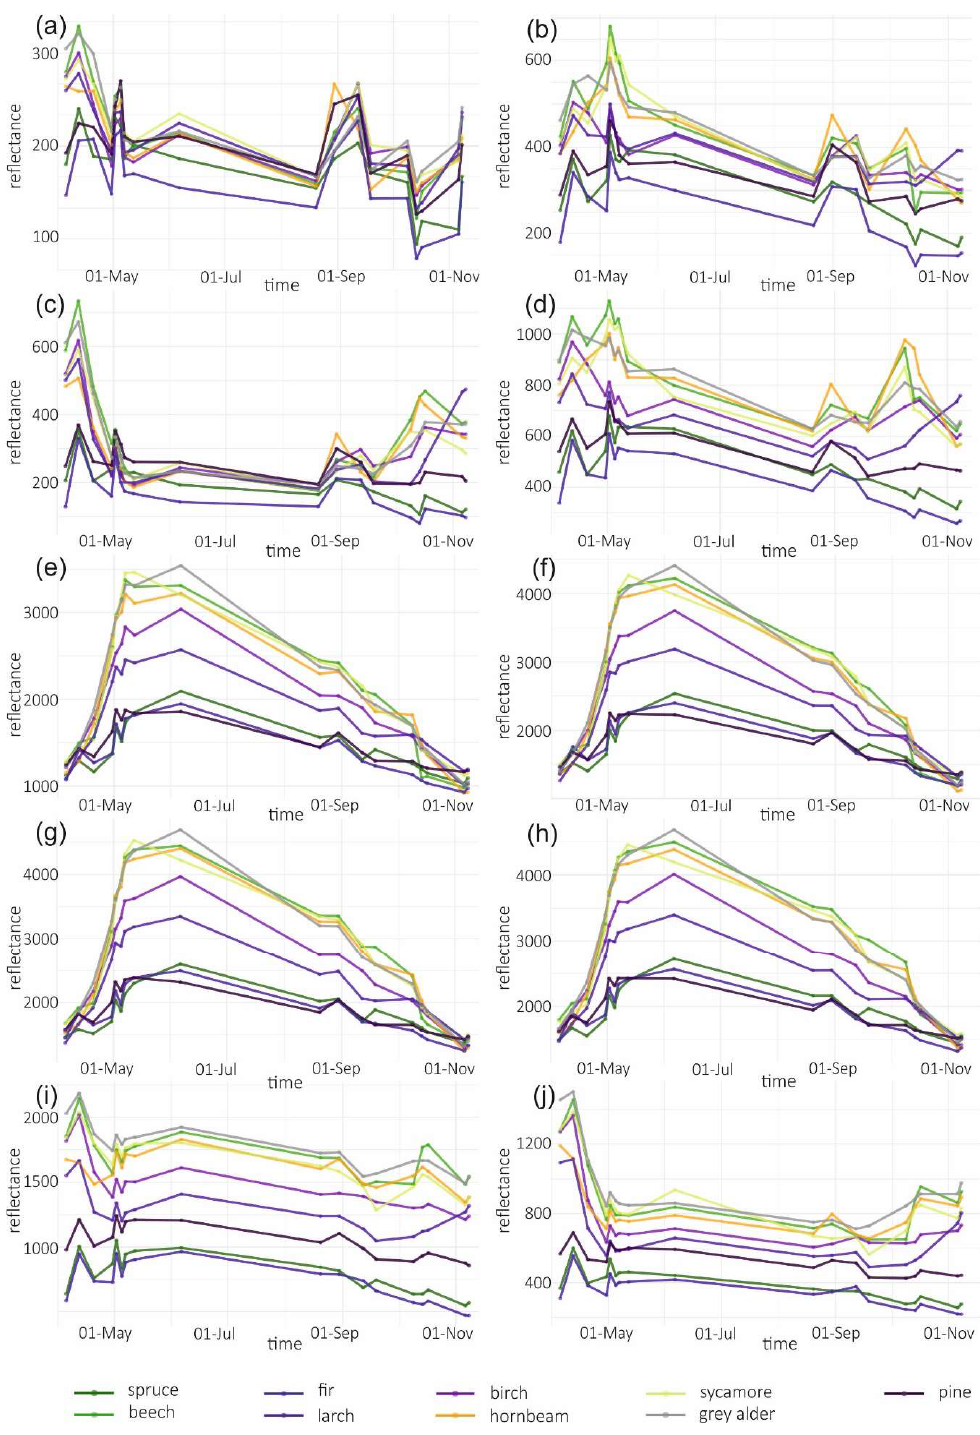
Figure 6. Temporal phenological patterns for the Baligród Forest District; S2 bands: ( a ) visible blue, ( b ) visible green, ( c ) visible red, ( d ) red edge 1, ( e ) red edge 2, ( f ) red edge 3, ( g ) near-infrared 1, ( h ) near-infrared 2, ( i ) short-wave infrared 1, and ( j ) short-wave infrared 2. The temporal patterns with standard deviations values can be found in Appendix A.